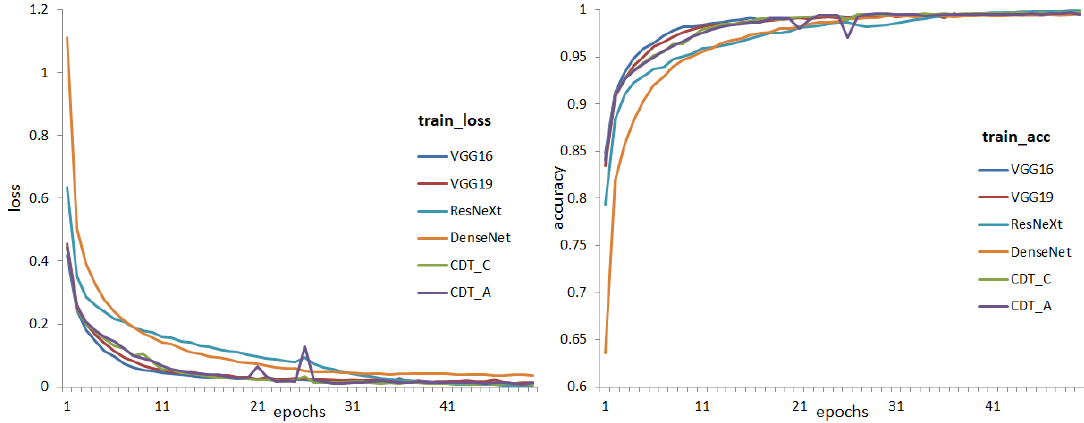
Figure 9. Compared results on FMNIST.